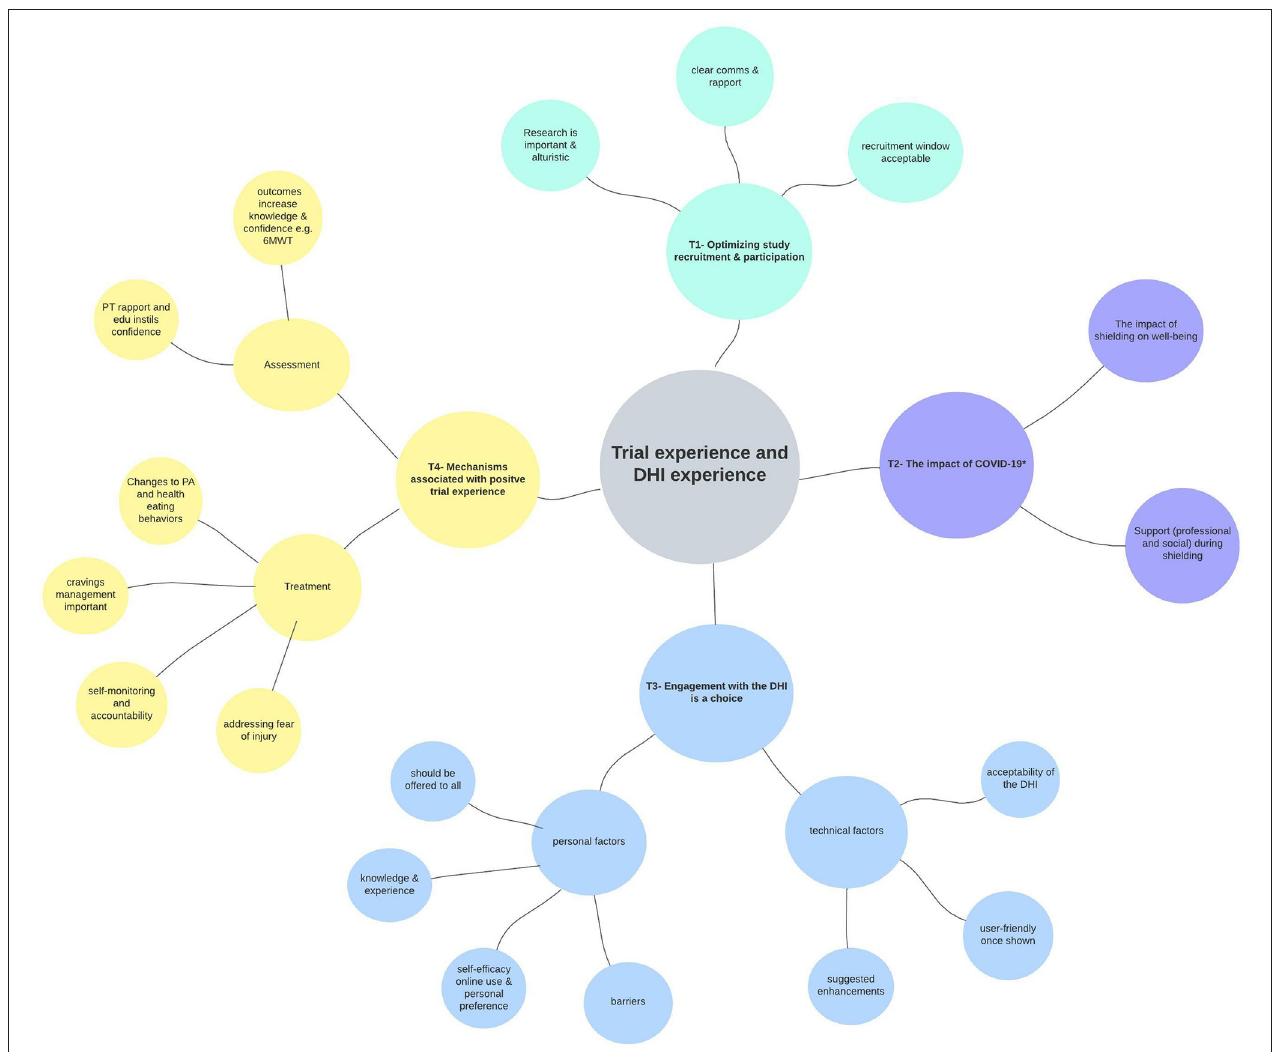
FIGURE 4 | Thematic map from reflexive thematic analysis ( n = 13). Key themes are represented in different colors. The research question is shown at the center of the diagram, with outward branching themes (T1 to T4), and subthemes from the qualitative analysis. The * in Theme 2 above depicts the first wave of COVID-19 and the shielding enforced to Kidney Transplant Recipients (23rd March 2020 to the 1st of August 2020). Ax, assessment; comms, communication; DHI, digital health intervention; edu, education; PA, physical activity; PT, physiotherapist; tech, technical; 6MWT, six-minute walk